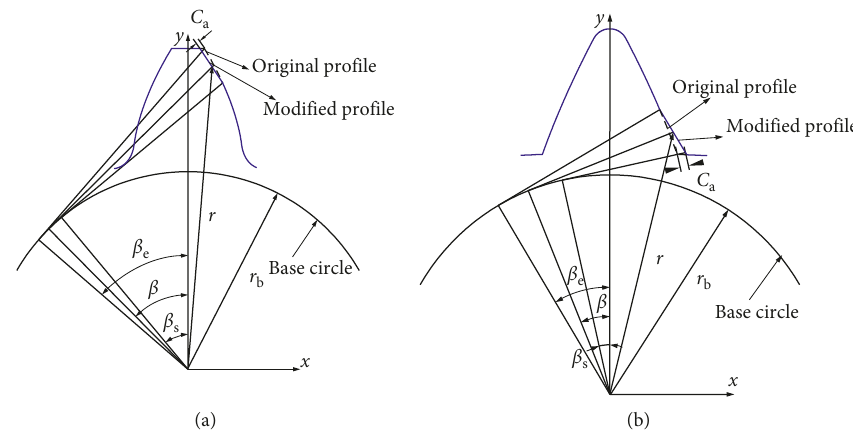
Figure 1: The schematic of tooth tip relief: (a) external gear and (b) internal gear.